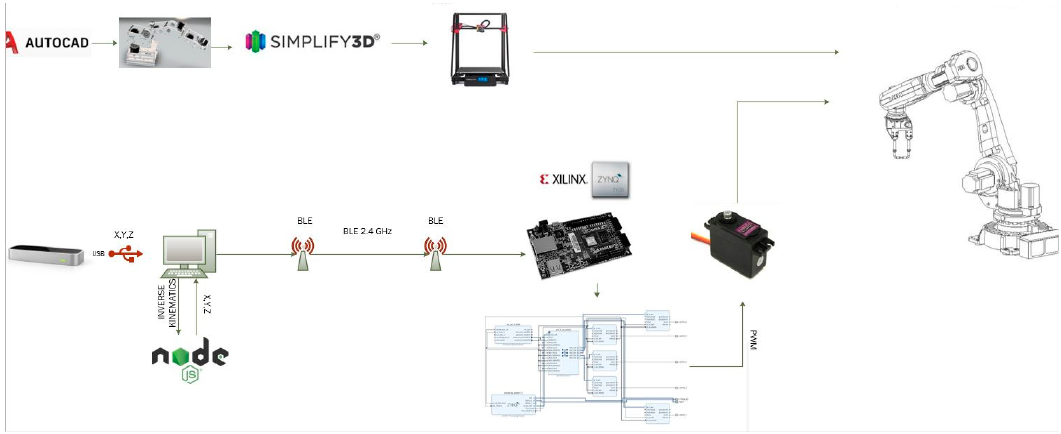
Figure 7. Robotic arm subsystem.